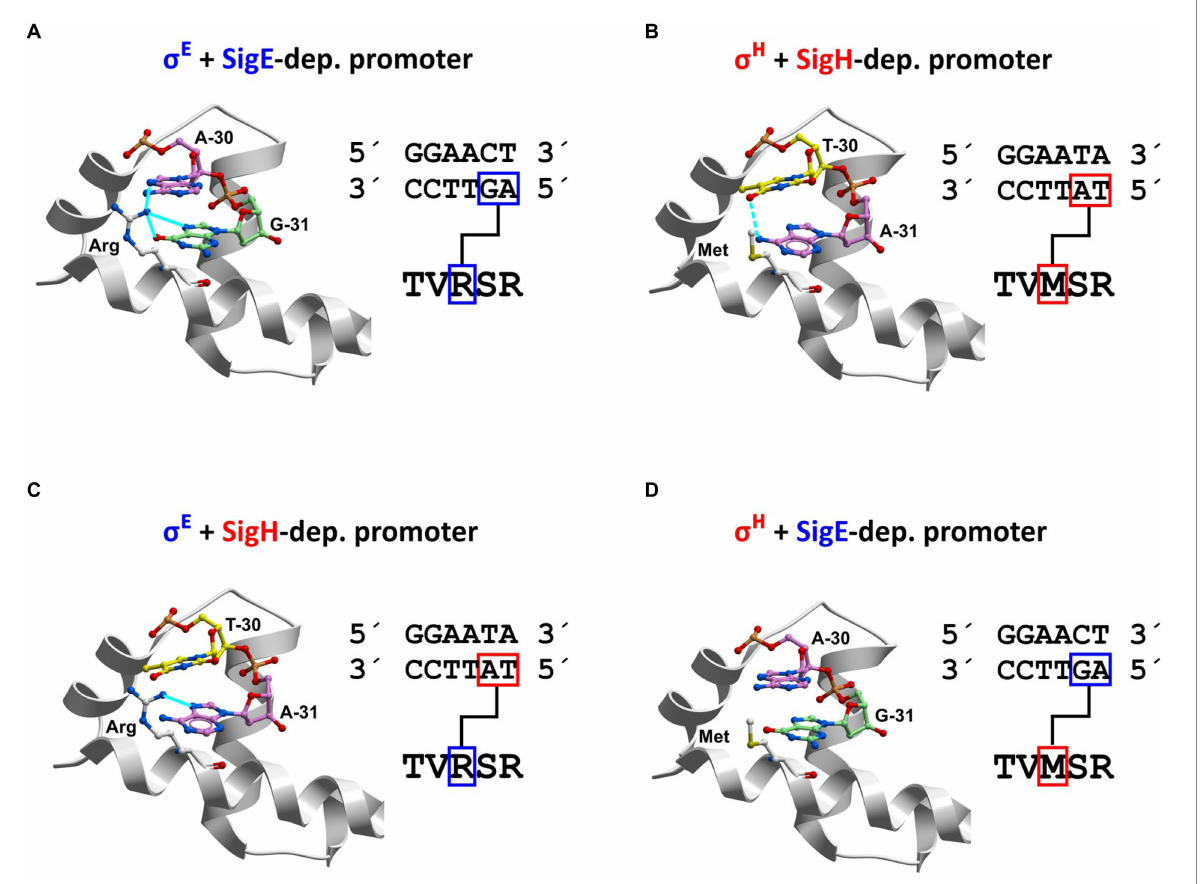
FIGURE 10 Recognition of nucleotides at promoter positions − 31 and − 30 within non-coding (template) strand by σ E and σ H (homology modeling). The − 35 sequences of the predominantly σ E -dependent promoter P cg3309 and exclusively σ Η -dependent promoter P trxB1 are shown. Four unique combinations of the key interacting partners (amino acids R/M and dinucleotides at positions − 31 G/A, − 30 A/T) can occur (i.e., R-GA, M-AT, R-AT, M-GA). DNA: red = oxygen; blue = nitrogen; A: purple = carbon; T: yellow = carbon; G: green = carbon. Amino acids: white = carbon; blue = nitrogen; yellow = sulfur; red = oxygen. Interactions: (A) Arg-GA; (B ) Met-AT; (C) Arg-AT; (D) Met-GA. Arginine R has a positively charged side chain, which forms stabilizing salt bridges with negatively charged phosphate groups of nucleic acids. In our models, the arginine side chain can form stabilizing hydrogen bonds with neutral nucleic acid bases G and A in the complex of σ E with predominantly σ E -dependent promoters (P cg1121, − 31 − 30 P cg3309 , P sigB or P cseE ; Figure 11A). In contrast, if the hydrophilic side chain of R is pushed into the immediate vicinity of the hydrophobic methyl group of T (as in the case of σ E and P trxB1 ; Figure 11C), it will prevent hydrophilic R from coming into energetically advantageous contact with − 30 water molecules. Therefore, the close interaction of R with the T base can destabilize complexes of σ subunits and promoters (Figure 11C). − 30 Methionine (M) is a hydrophobic amino acid that does not form hydrogen bonds with nucleic acid bases. From the point of view of the overall energy of the system, it is advantageous if the hydrophobic motifs come together, which allows the surrounding water molecules to form the maximum number of hydrogen bonds. Therefore, the stabilizing interactions can occur upon contact of M with the hydrophobic methyl group of T of the template strand (in P trxB1 , P rshA , and P mshC ; Figure 11B). If the hydrophobic side chain of methionine comes close to G A as in − 30 − 31 − 30 P cg3309 , neither hydrogen bonds nor hydrophobic interaction can be formed and a weak coupling results (Figure